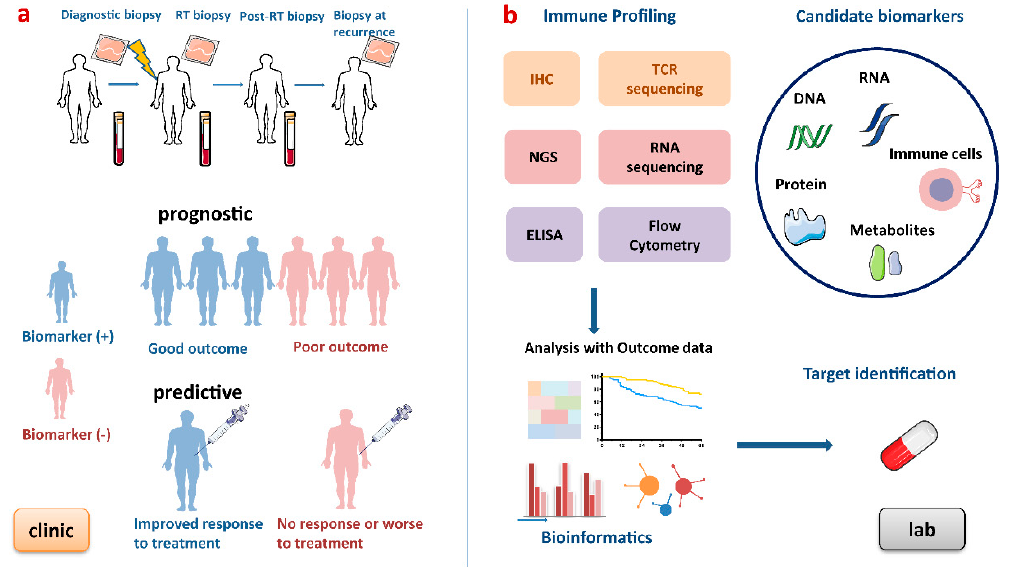
Figure 3. Process of developing biomarkers for patients undergoing radiotherapy. ( a ) Blood and tumour biopsies are taken at baseline, during RT, after RT and at recurrence to obtain dynamic immune profiling. This figure shows an ideal example of prognostic and predictive biomarkers. Prognostic biomarkers provide information on disease progression and outcomes, and predictive biomarkers indicate the response to a medical intervention. ( b ) In the lab, these biomarkers can be discovered by high-throughput gene technologies, immune-based technologies and analysed by bioinformatic approaches. RT, radiotherapy; IHC, immunohistochemistry; NGS, next-generation sequencing; TCR, T cell receptor; ELISA, enzyme-linked immunosorbent assay.